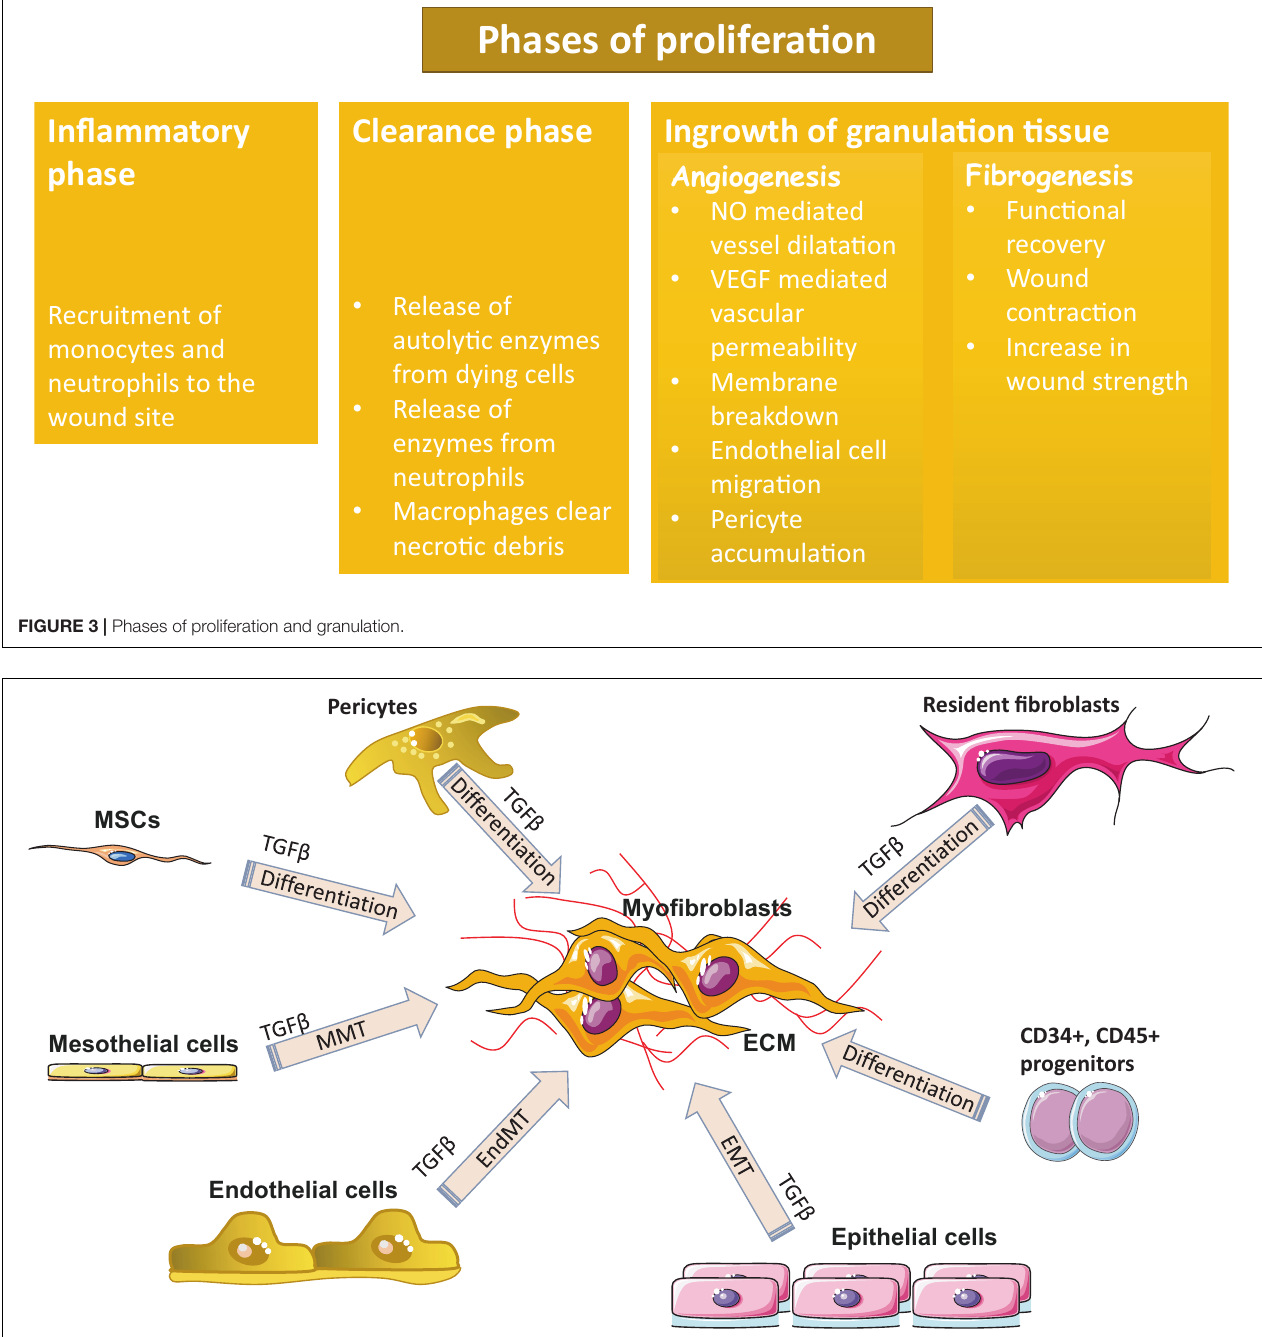
increasing number of mesenchymal cells will aggravate